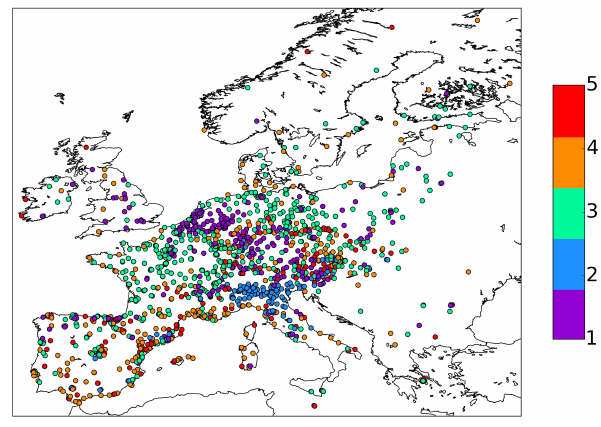
Figure 3. Map of 1492 Airbase stations clustered in five groups; first